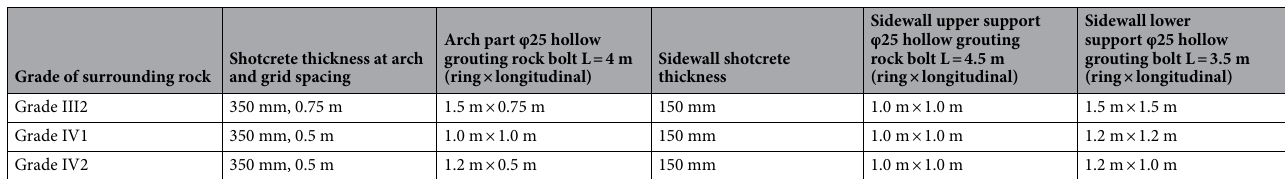
Table 2. Supporting parameters of primary structure.